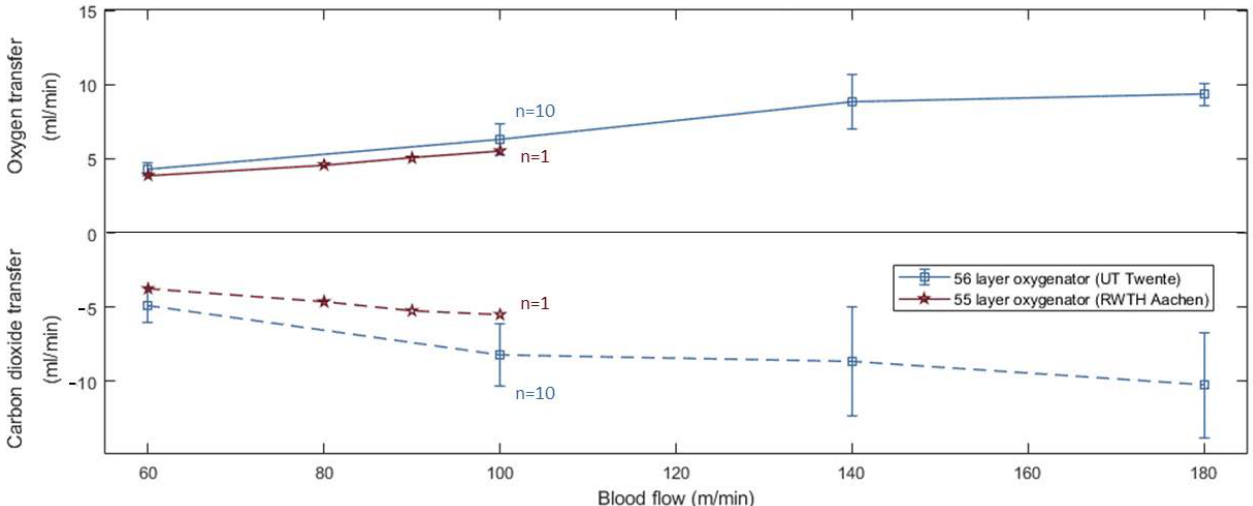
Figure 6. Oxygen and carbon dioxide transfer rates over blood flow. Blue: n = 10 experiments with 56 fiber layer oxygenators manufactured and tested at Twente University. Red stars: Similar experiments with a single 55- layer mat oxygenator, manufactured and tested at the University Hospital Aachen (identical data also previously shown in Figure 5). Solid lines: Oxygen transfer performance, broken line: Carbon dioxide transfer performance.